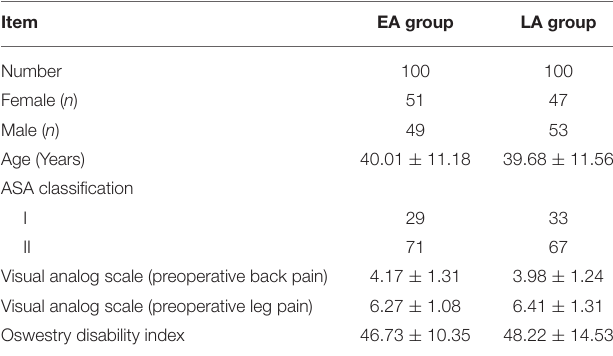
TABLE 1 | Demographic characteristics of patients in two groups.